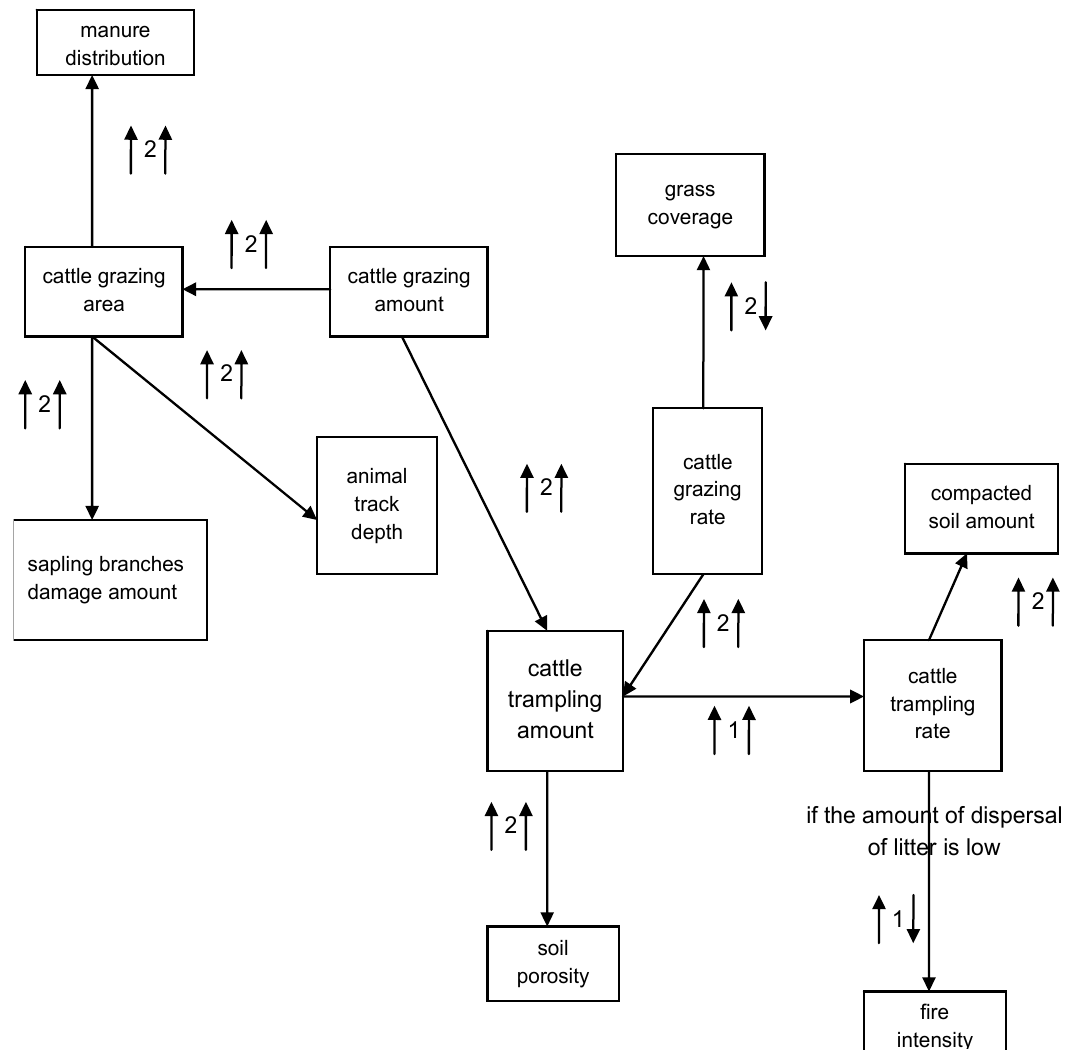
Figure 5. Karen and Palong farmers’ perception of cause-and-effect relationships around forest fire control and leaf litter dispersal. Source: Generated with AKT5, based on data from interviews and focus group